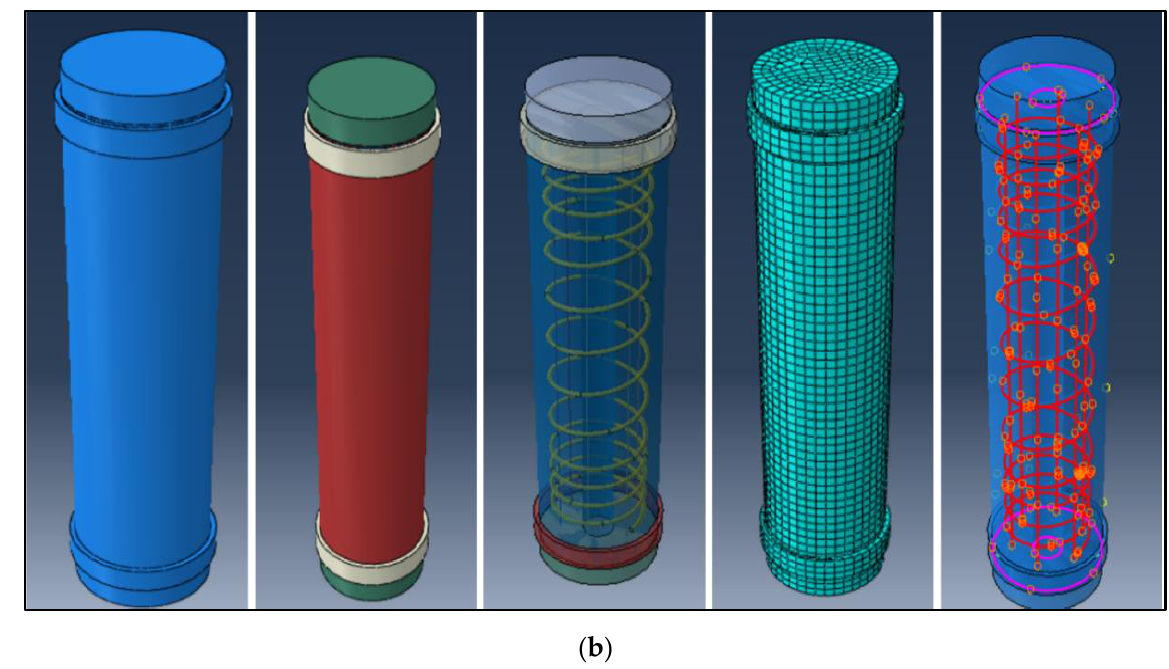
Figure 5. Modeling: ( a ) individual parts, ( b ) assembled parts. Figure 5. Modeling; ( a ) individual parts and ( b ) assembled parts.